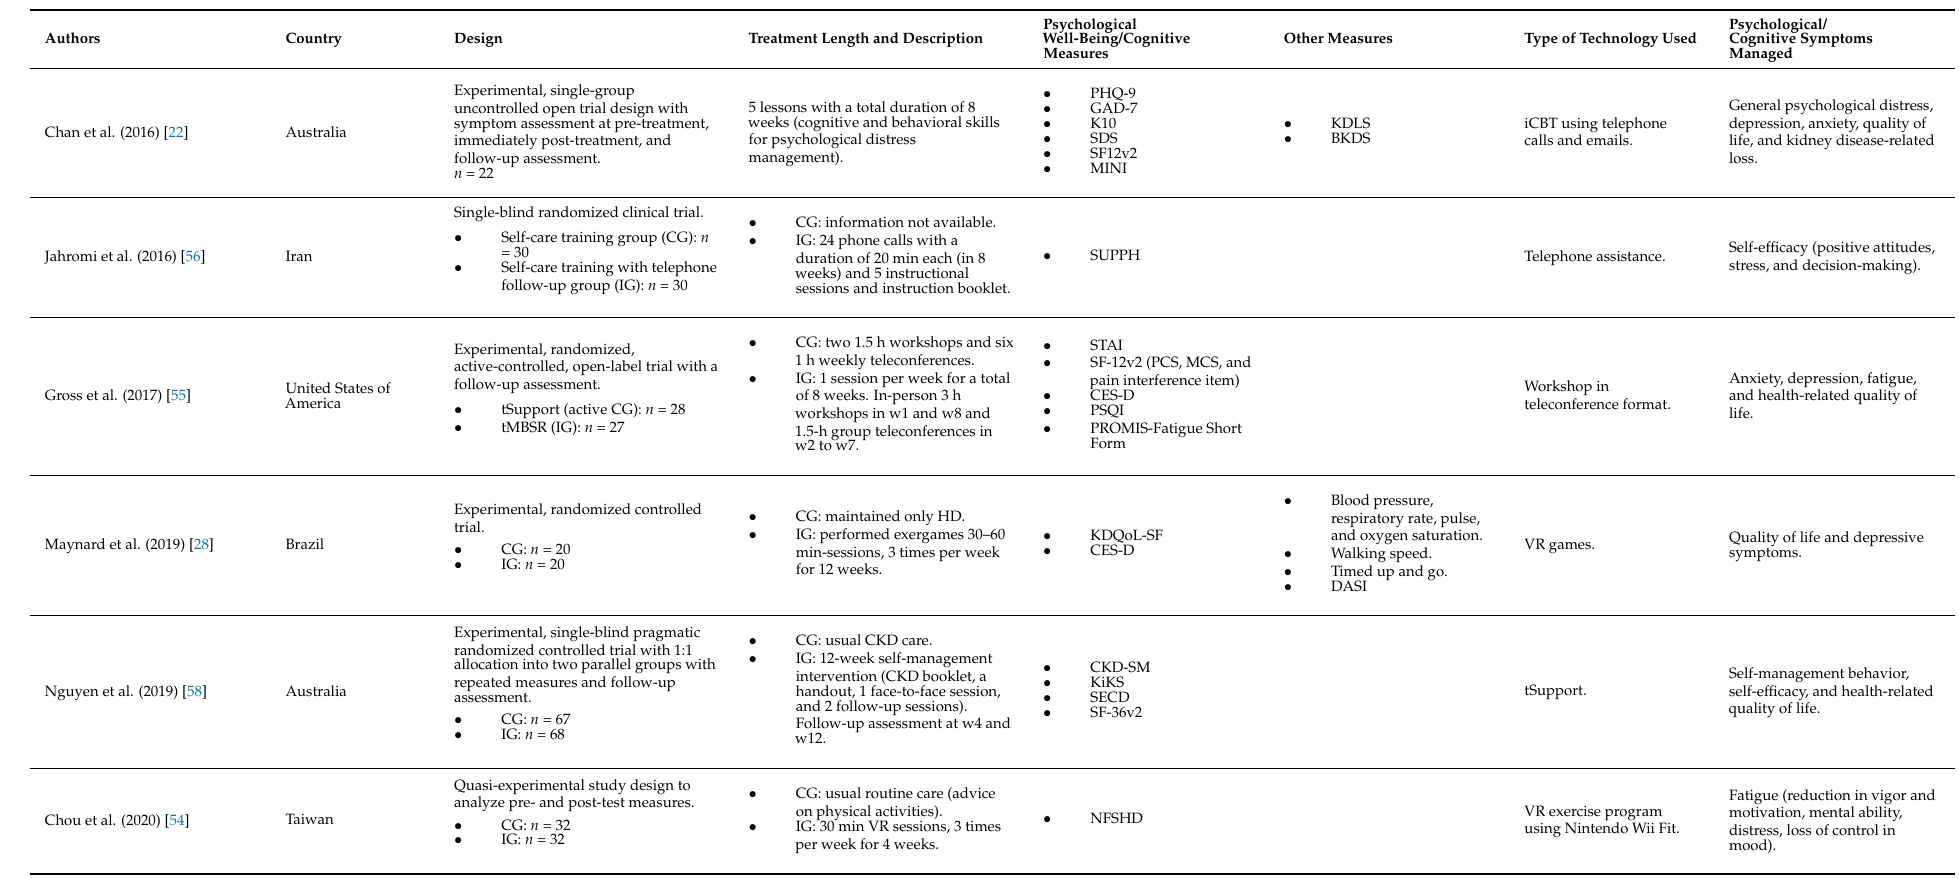
Table 3. Main characteristics of the included papers: authors (year), country, design, length of study, psychological and/or cognitive measures, other measures, type of technology used, and psychological and/or cognitive symptoms